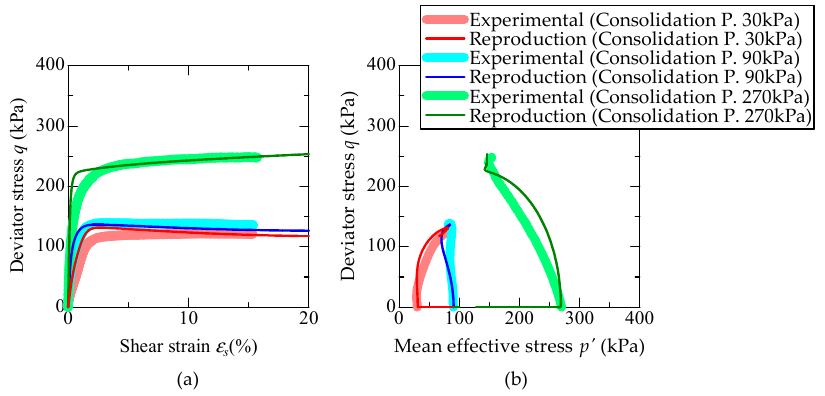
Figure 4. Undrained triaxial test of the Ylc layer (experimental and reproduction results): ( a ) Shear strain; ( b ) Mean effective stress.